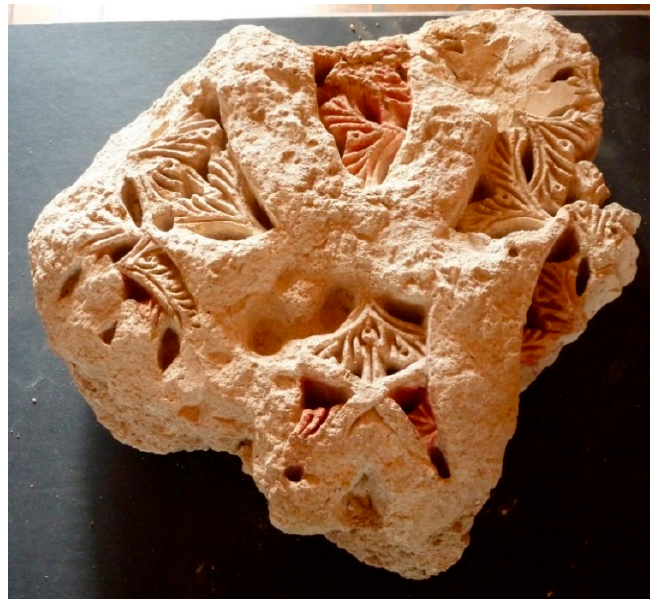
Figure 18. Panel fragment of Molina de Aragón Synagogue. Author’s photo.